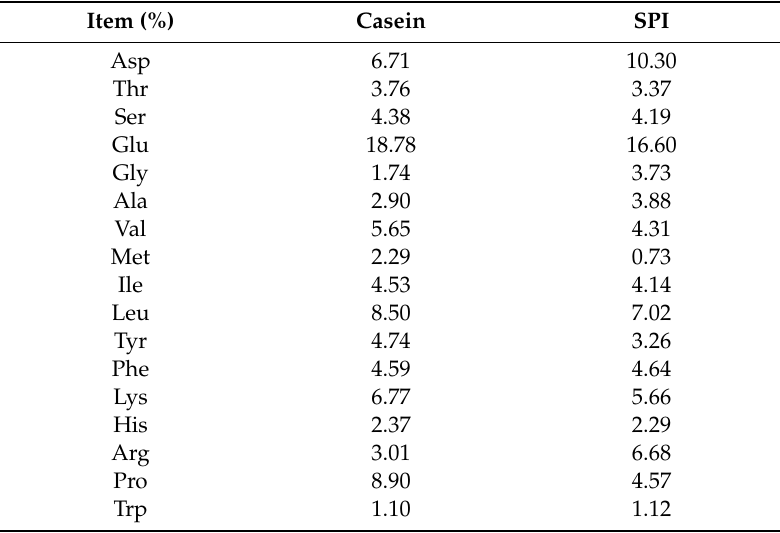
Table 1. Amino acid composition of casein and soy protein isolate (SPI), on a dry matter basis.